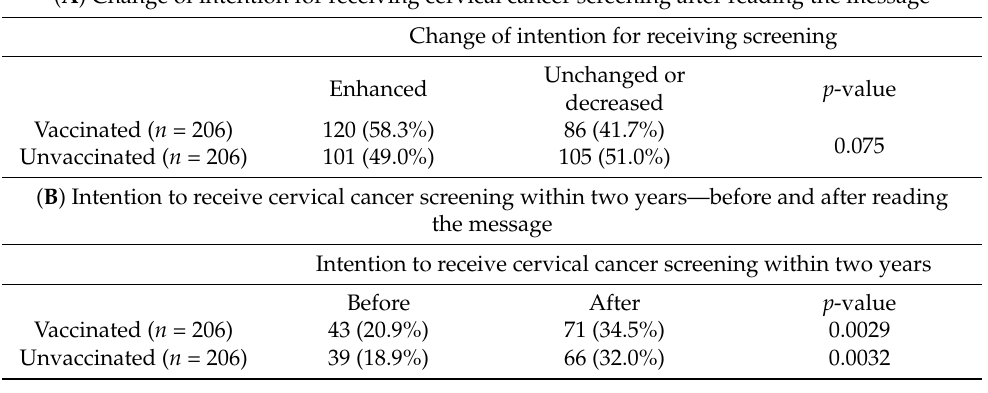
Table 3. Effects of the tailored or standard recommendation messages for cervical cancer screening for the vaccinated and unvaccinated